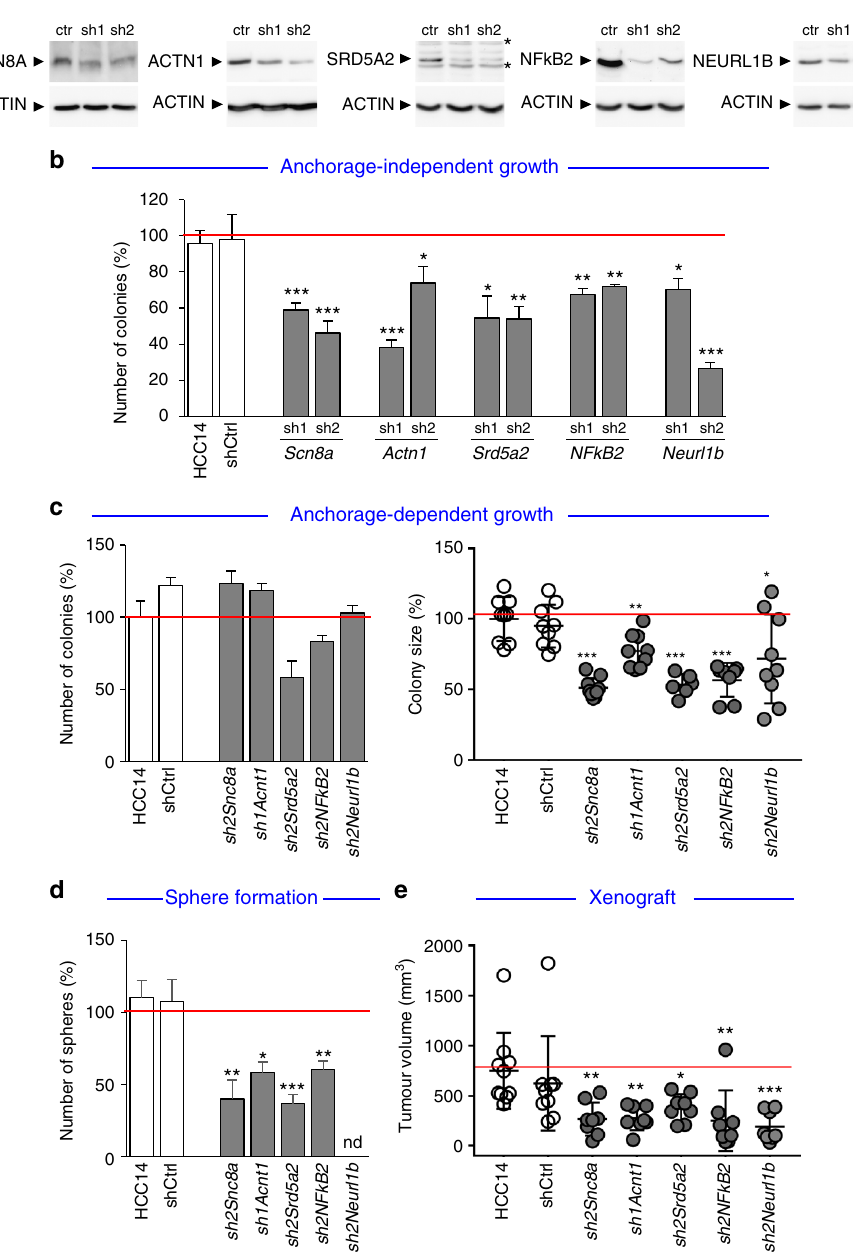
Fig. 7 Downregulation of overexpressed genes with hypermethylated gene body CGI in Alb-R26 Met HCC cells interferes with their tumorigenic properties both in vitro and in vivo. a Western blots showing SCN8A, ACTN1, SRD5A2, NFkB2 and NEURL1B protein levels in stable clones established after transfection of Alb-R26 Met HCC14 cells with plasmids carrying a shRNA sequence targeting the corresponding gene. Protein levels were compared to control cells (ctr). ACTIN was used as a loading control in all western blots. The asterisk indicates nonspeci fi c bands detected using anti-SRD5A2 antibodies. b – e Biological assays to assess functional properties of Alb-R26 Met HCC14 cells carrying a shRNA sequence targeting candidate genes. Effects were compared to HCC14 cells either untransfected or transfected with a control shRNA (shCtrl). b Graph reporting the number of colonies formed in anchorage-independent growth assays using 2 different shRNA targeting sequences for each candidate gene. Note a decrease in colony number formation of cells with downregulated candidate genes compared with control cells. c Graphs reporting the number (left) and the size (right) of colonies formed